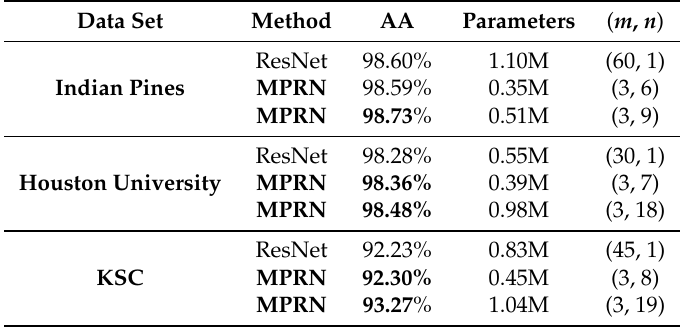
Figure 7. The average accuracy of ResNet with various network depth m on the ( a ) Indian Pines, ( b ) Houston University, and ( c ) KSC data sets. Table 3. Average accuracy comparison between ResNet and MPRN with different model sizes. The best results are highlighted in bold